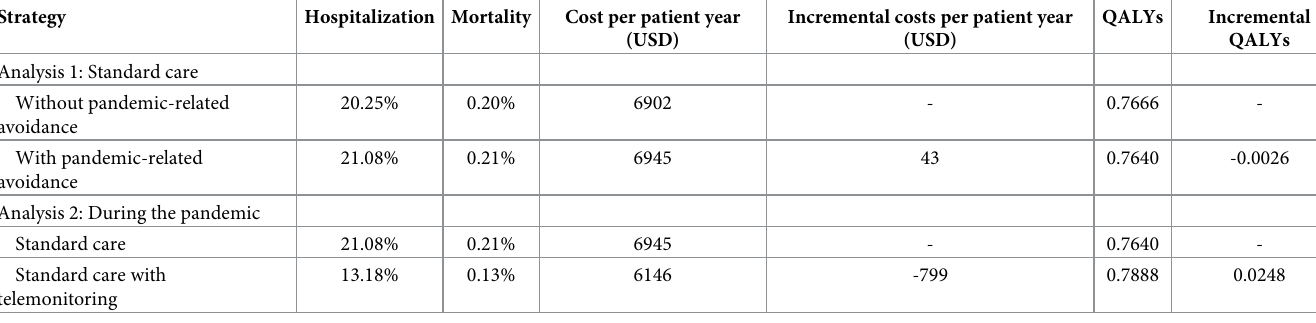
Table 2. Expected base-case